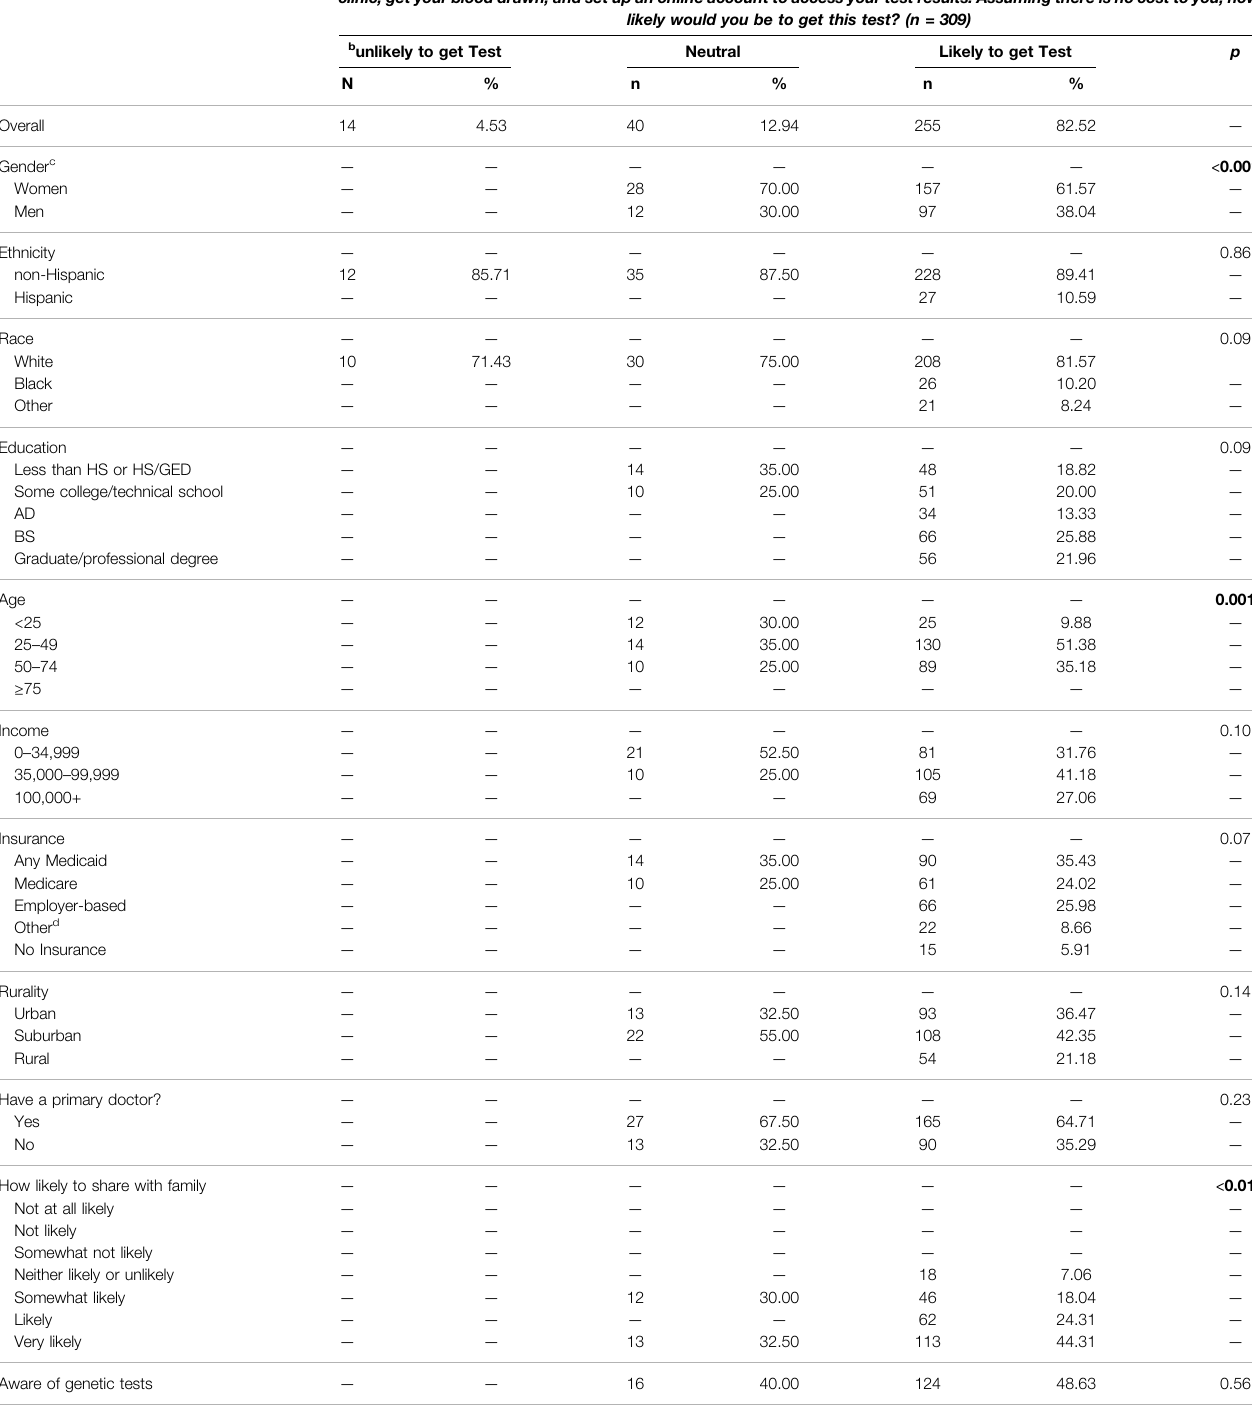
TABLE 4 | Descriptive characteristics among those with different likelihoods of getting a population genetic screening test for cancer risk. Characteristics